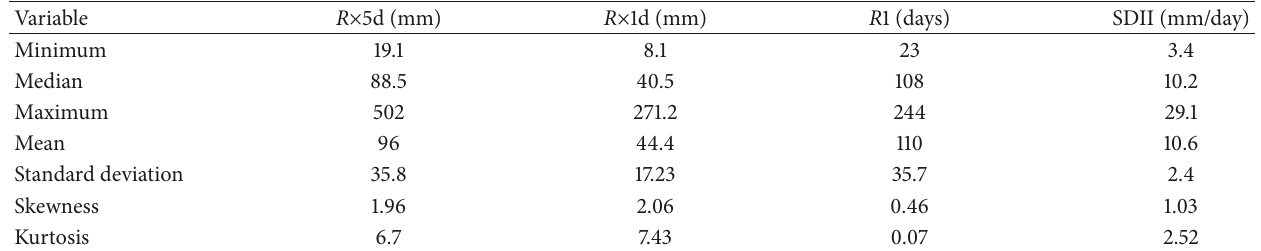
Table 3: Summary statistics of the precipitation indices for the period 1985–2015.